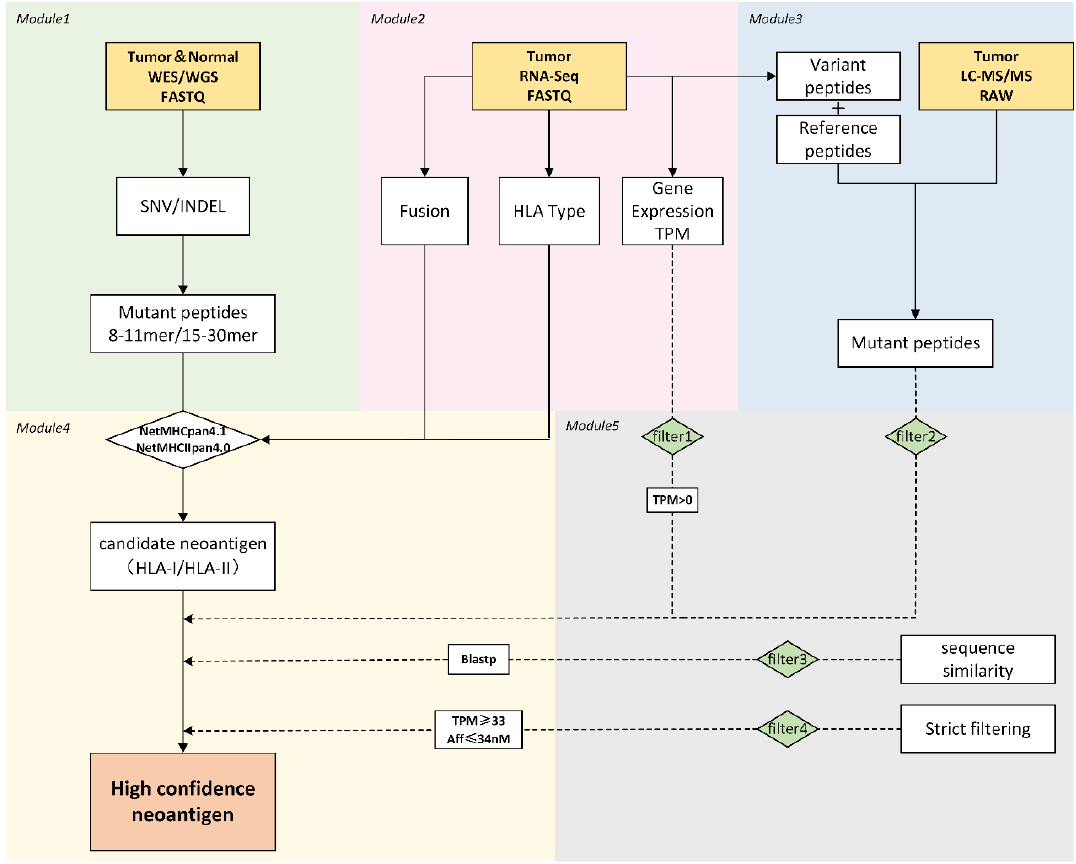
Figure 1. Workflow of ProGeo-neo v2.0. Including detection of SNV/INDEL based on tumor/normal WGS/WES data; HLA allele prediction, gene fusion detection, and gene expression detection based on tumor RNA-seq data; neoantigen screening by raw proteomics data (LC-MS/MS); neoantigen prediction (peptides-HLA class I/II); screening and filtering of candidate neoantigens.